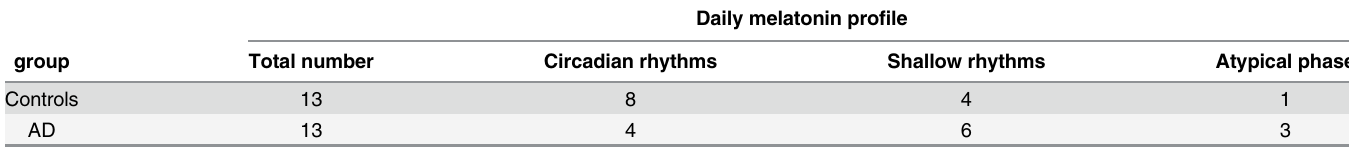
Table 1. Summary of the individual melatonin profile characteristics in controls and AD